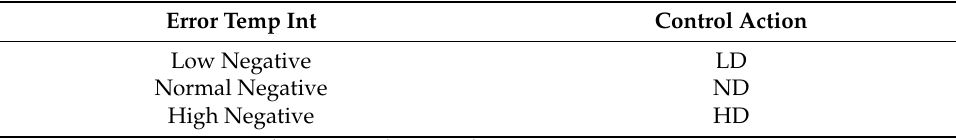
Table 3. Ventilation control rules. Error Temp Int Control Action Low Negative LD Normal Negative ND High Negative HD LD: Lower Descent, ND: Normal Descent and HD: High